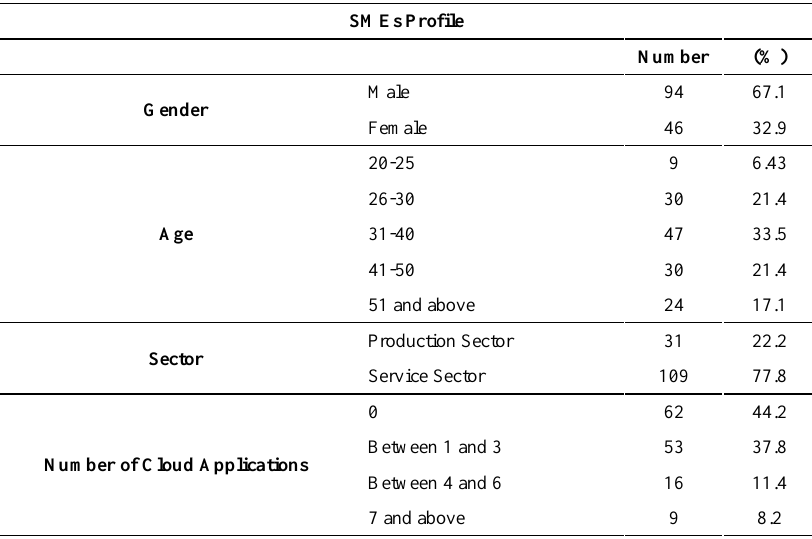
Table 1. Small and medium enterprises (SMEs) profile of the